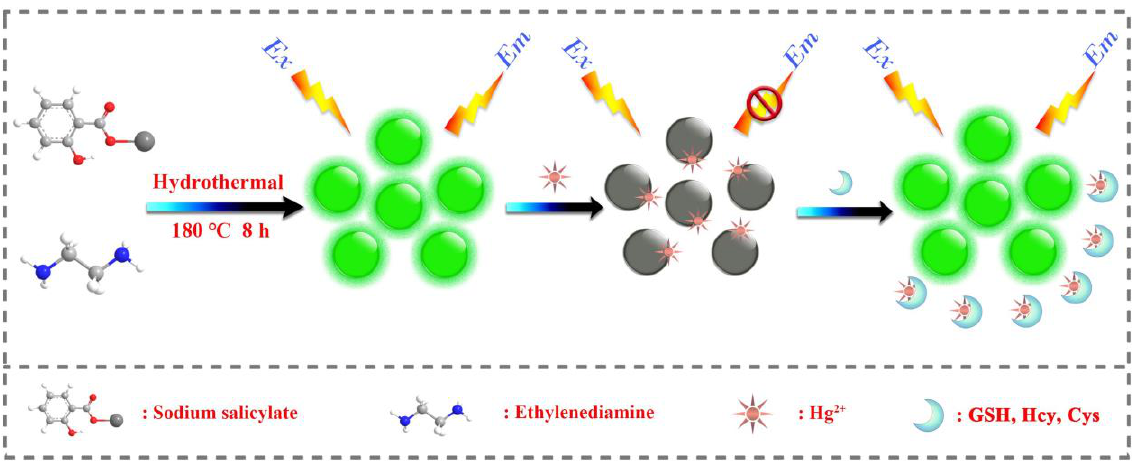
Figure 4. Schematic illustration of the synthesis process of fluorescent CDs and detection principle for Hg 2+ and biothiols (reproduced with the permission from Ref. [92]).